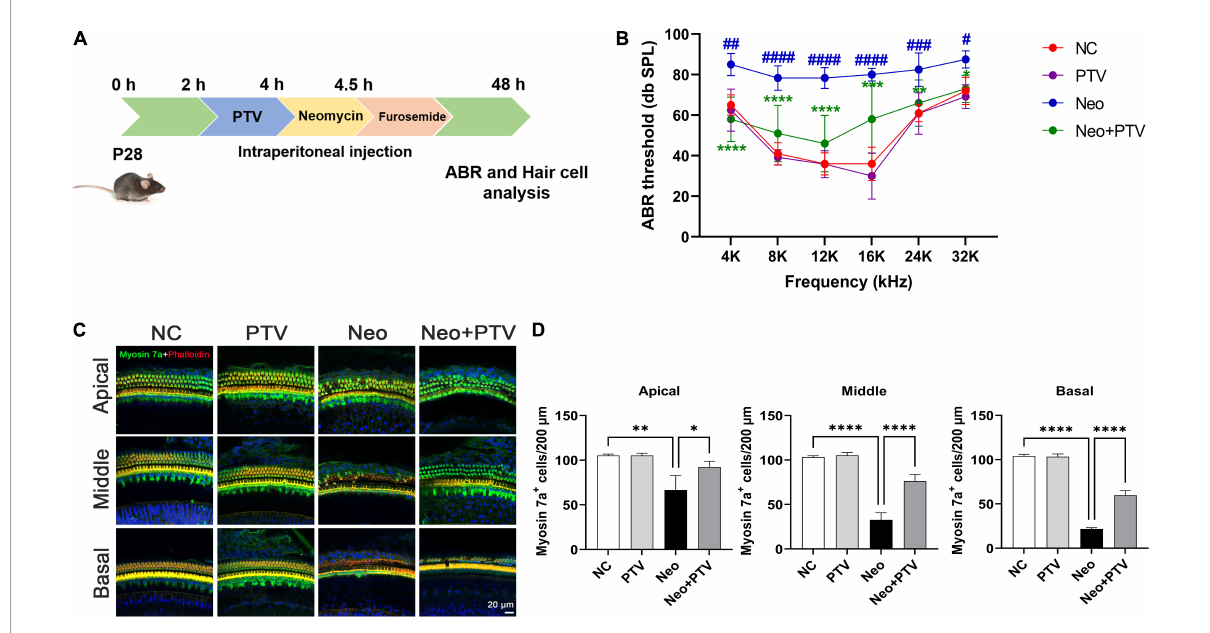
FIGURE2 PTV promotes auditory function recovery and prevents neomycin-triggered hair cell loss in vivo . (A) Procedure of the experiments in vivo . (B) Auditory function of mice was detected using ABR method ( n = 6). (C) Immunofluorescence of mouse cochlear hair cells stained with myosin 7a and phalloidin in the apical, middle, and basal turns. Scale bars = 20 µ m. (D) Counting of the amount of cochlear hair cells per 200 µ m in mice ( n = 3). # p < 0.05, ## p < 0.01, ### p < 0.001, #### p < 0.0001 vs. NC group; * p < 0.05, ** p < 0.01, **** p < 0.0001 vs. Neo group.